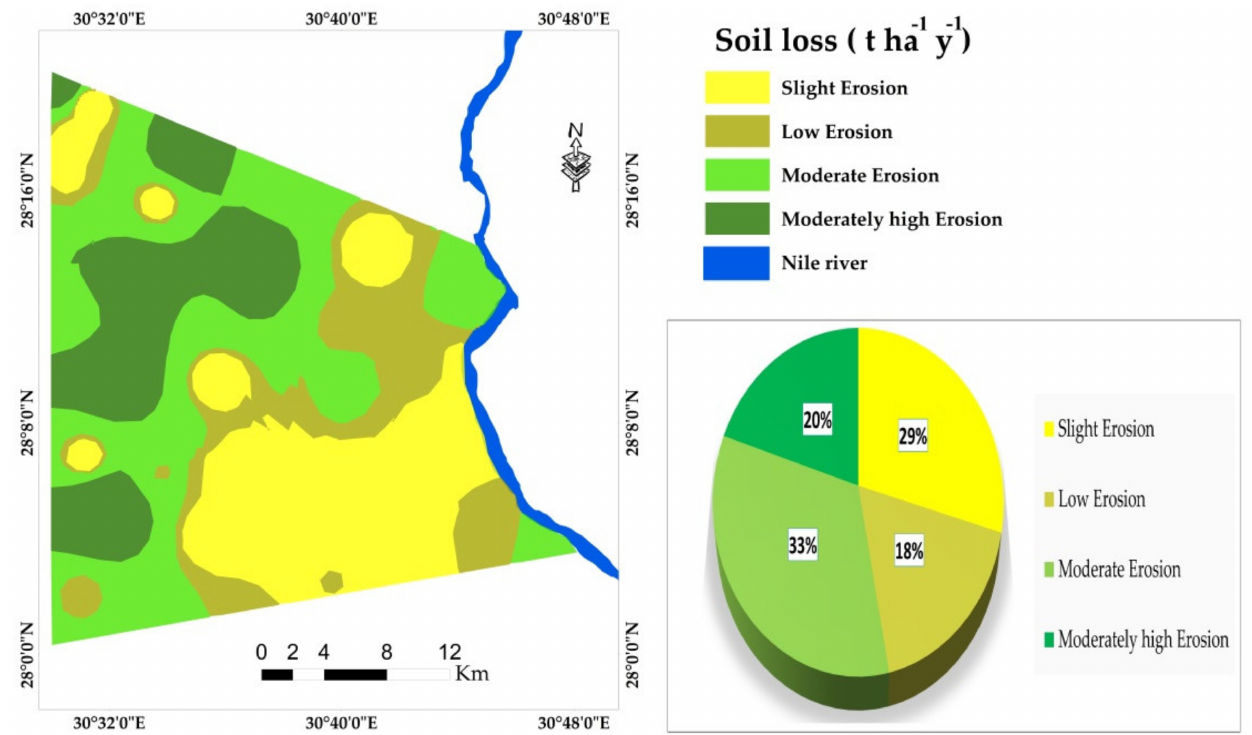
Figure 9. Spatial distribution of soil loss (t h − 1 y − 1 ) within investigated area and a pie chart repre- senting the percent of soil erosion